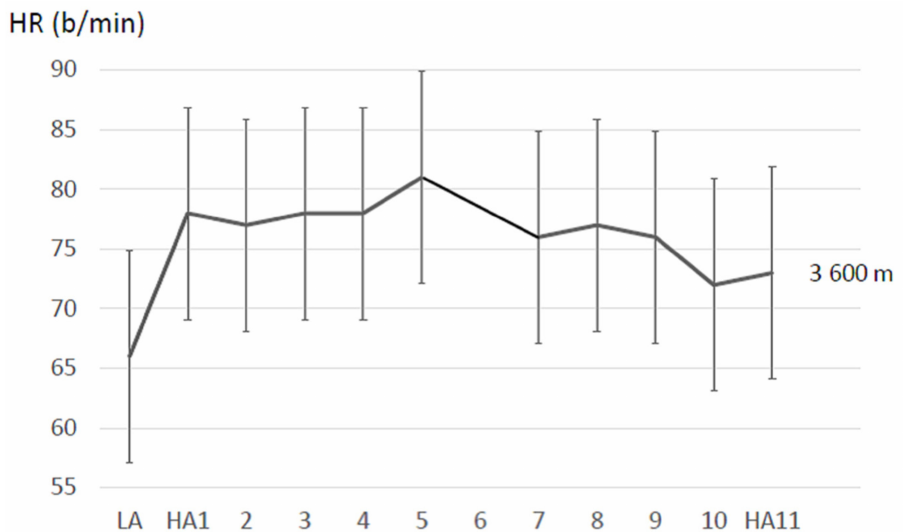
Figure 4. Example for changes of heart rate (HR) when acutely ascending from low (LA) to high altitude (HA1) and during the subsequent day acclimatization period at 3600 m based on a study with young soccer players (16 ± 0.4 years) [51]. HR data were collected in the morning after awakening with a Polar Team system (Polar Electro Oy, Kempele,